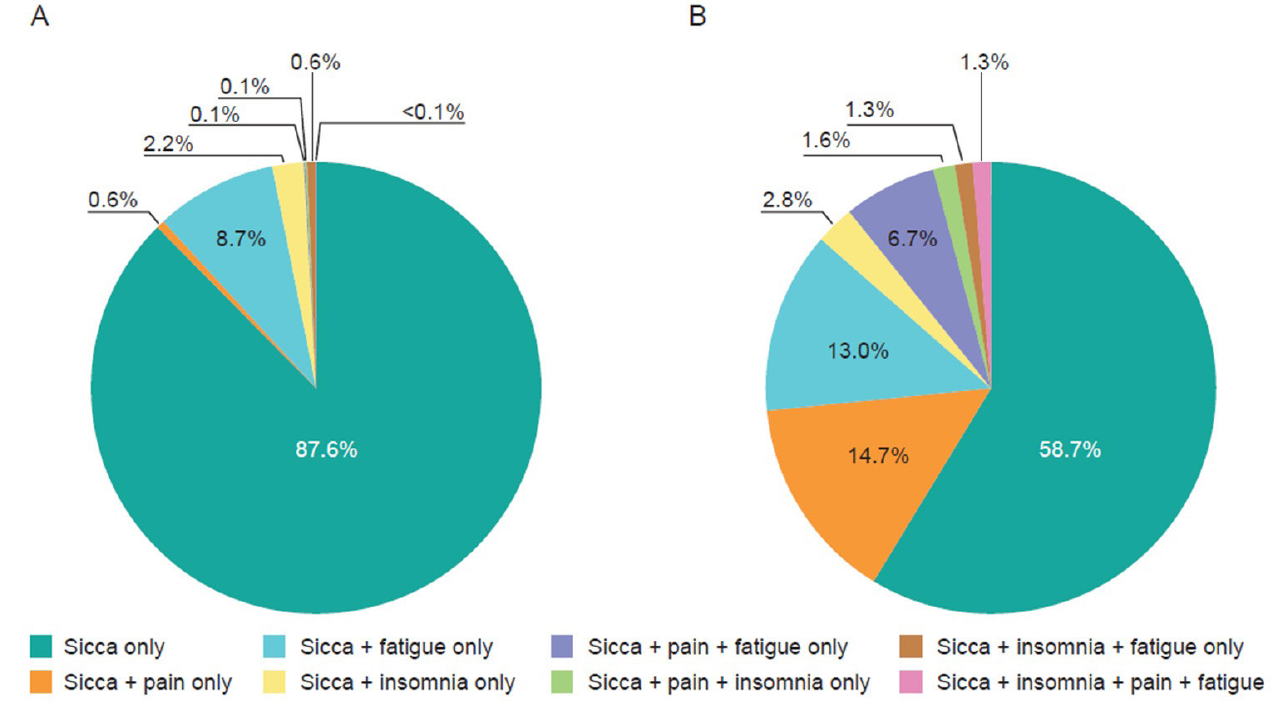
pSS: primary Sjögren’s syndrome Figure 3. Distribution of Clinical Characteristics Reported in Patients with Sicca with A) Glandular Disease or B) Extra-glandular Disease (Primary